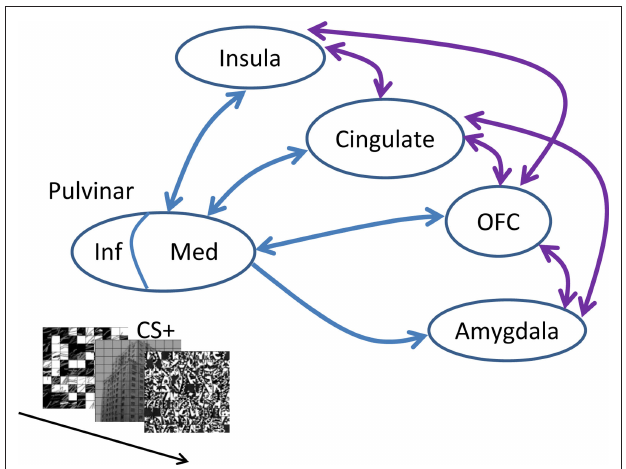
Figure 5 | Affective significance and the pulvinar. When weak, though affectively significant stimuli are encountered (as shown in the inset), interactions between the medial (Med) pulvinar and several brain regions important for the determination of “biological value” influence the flow of information processing, such that signals related to such items are amplified, thus leading to increased behavioral effects. Note that only some of the connections between the amygdala, orbitofrontal cortex (OFC), cingulate, and insula are provided (shown in purple). In contrast to the medial pulvinar, which is largely “associational,” the inferior (Inf) pulvinar is bidirectionally connected with striate and extra-striate cortex, and is thus much more